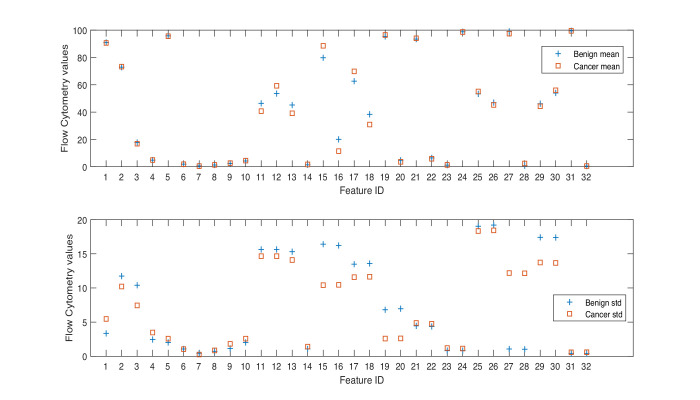
Mean and standard deviation values of flow cytometry features.